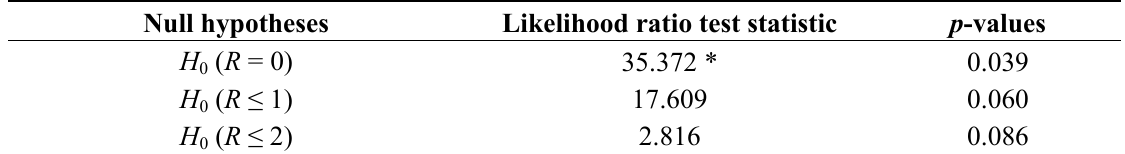
Table 4. Results of Johansen co-integration